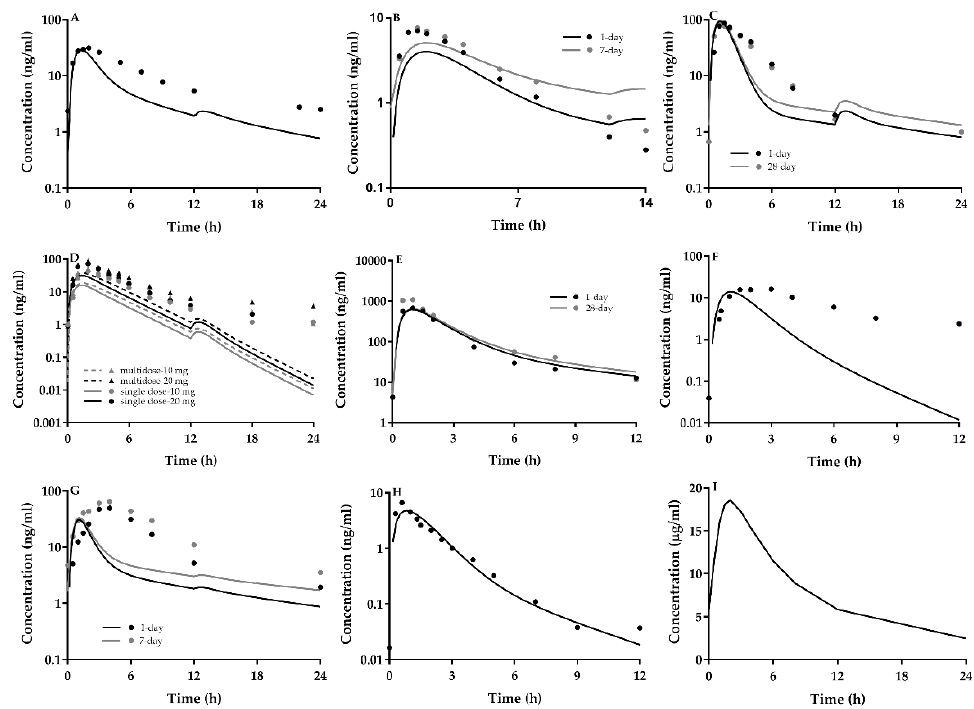
Figure 2. Predicted plasma concentrations (line) of the victim drugs agents using the PBPK model and observed plasma concentrations (points) following oral administration to subjects when co-administered with CsA (twice daily). ( A ) atorvastatin; ( B ) cerivastatin; ( C ) pravastatin; ( D ) rosuvastatin; ( E ) fluvastatin; ( F ) simvastatin; ( G ) lovastatin; ( H ) repaglinide; ( I ) bosentan. Observed data were cited from clinic reports [14 – 21,23,24,92 – 96].